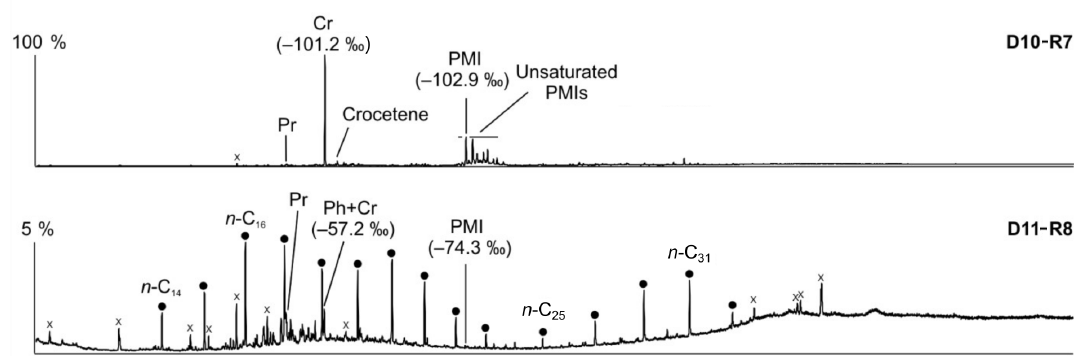
Figure 10. Total ion current (TIC) chromatograms of the analyzed samples. Isotopically depleted acyclic irregular isoprenoids such as Cr and PMI are typically found in settings influenced by the anaerobic oxidation of methane (AOM). Pr is pristane; Ph is phytane; Cr is crocetane; PMI is 2,6,10,15,19-pentamethylicosane; dots are n -alkanes; and crosses are siloxanes (septum or column bleeding). Percentage values given on the vertical axes of chromatograms relate peak intensities to highest peak (Cr in